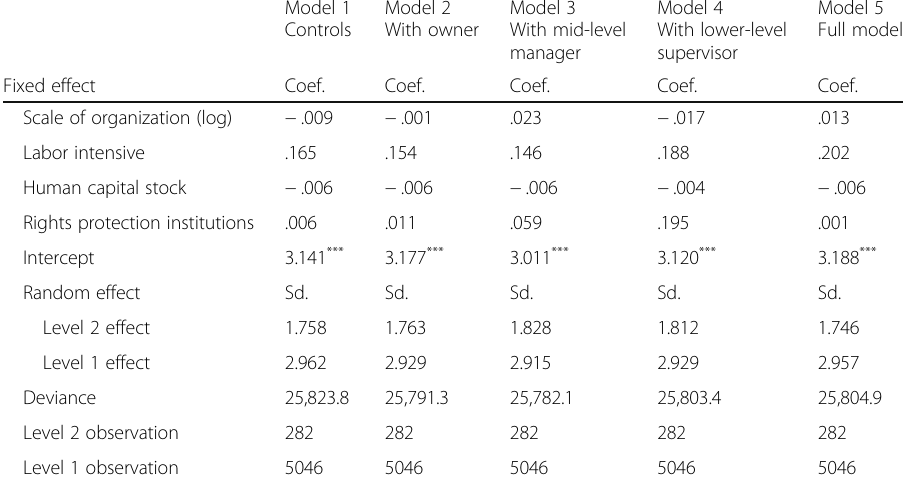
Table 4 Native-place ties and organizational commitment: a direct effect